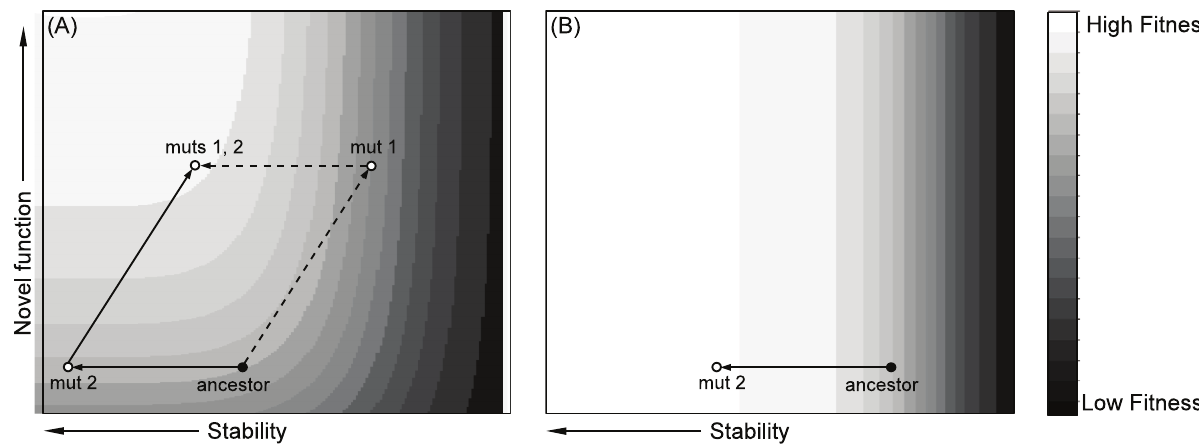
Figure 1. Mutational pathways to a novel function when function and stability trade-off. (A) Dashed line: mutation 1 on the ancestral background confers increase in novel function, but stability is decreased. If trade-off is severe, fitness may decline. Mutation 2 is compensatory and increases both stability and fitness. Solid line: mutation 2 on the ancestor does not affect function or fitness and is, thus, neutral, but pre-adapts the protein by increasing stability. Mutation 1 on the background of 2 then increases function and fitness. (B) Elevated temperature selects for increased stability in the absence of selection for a novel function. The protein is now pre-adapted should selection for a novel function arise later.